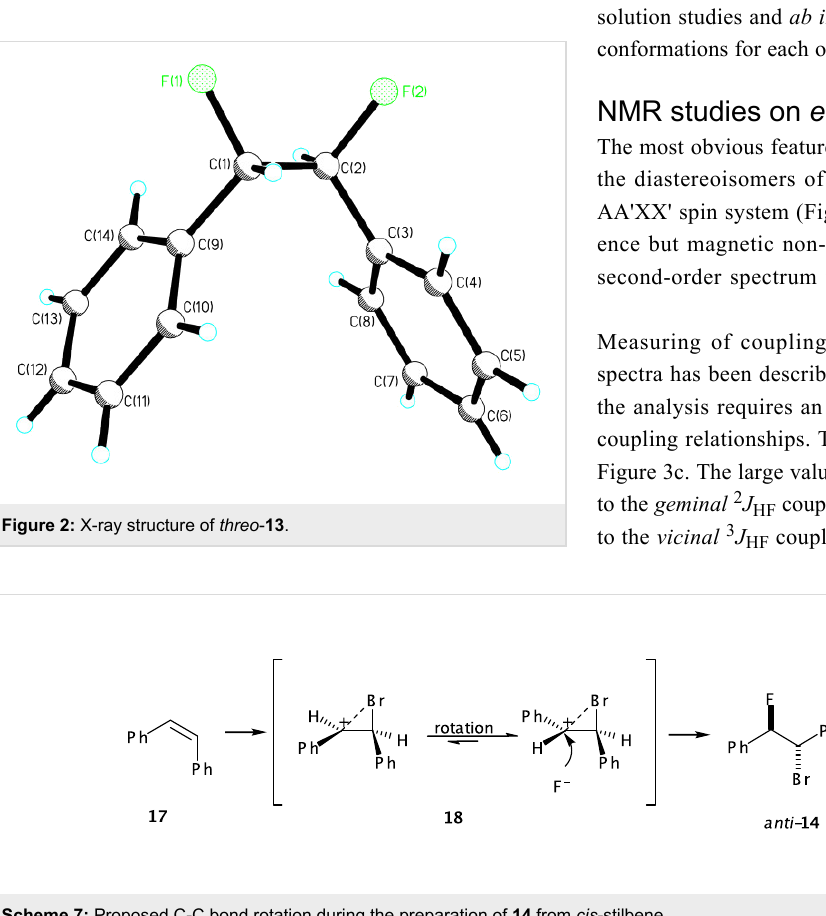
Isolation of the minor threo - 13 isomer required careful chroma- tography. In order to improve the synthesis of threo - 13 a reac- tion with cis -stilbene 17 was investigated. The one pot process with NBS, PPHF and Ag(I)F again proceeded smoothly however it also gave erythro - 13 as the major product of the reaction, although with a reduced diastereoisomeric ratio (47% de) more suitable for threo - 13 isolation. The bias towards erythro - 13 in this case is clearly a result of internal rotation about the central carbon-carbon bond, to relieve a steric clash between the vicinal phenyl groups, after initial formation of an intermediate bromonium ion 18 as illustrated in Scheme